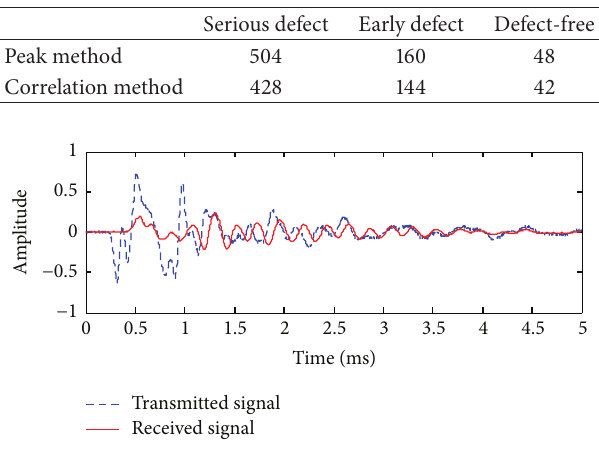
Figure 7: Transmitted and received